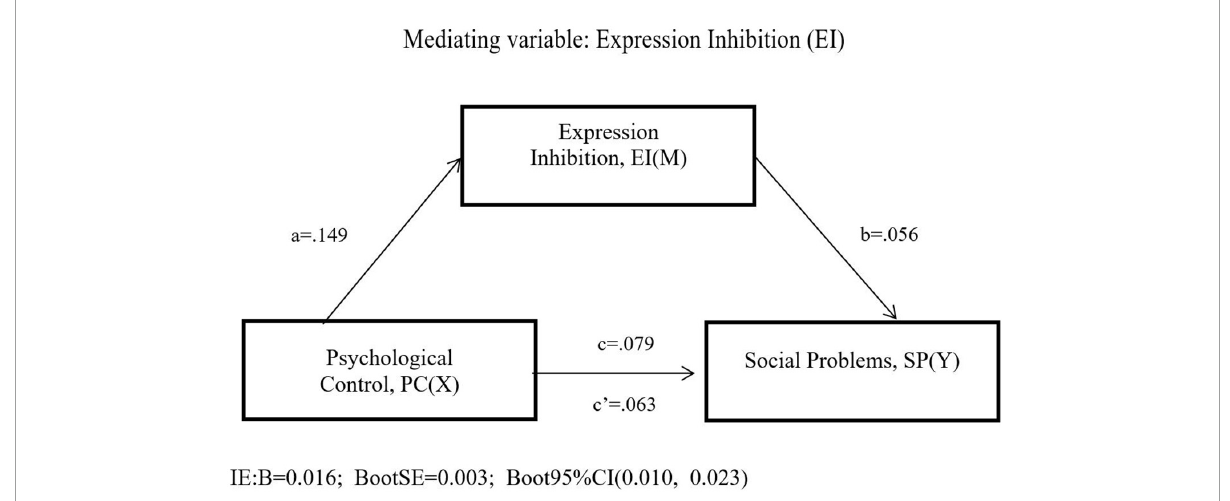
FIGURE3 The mediation model of expression inhibition.